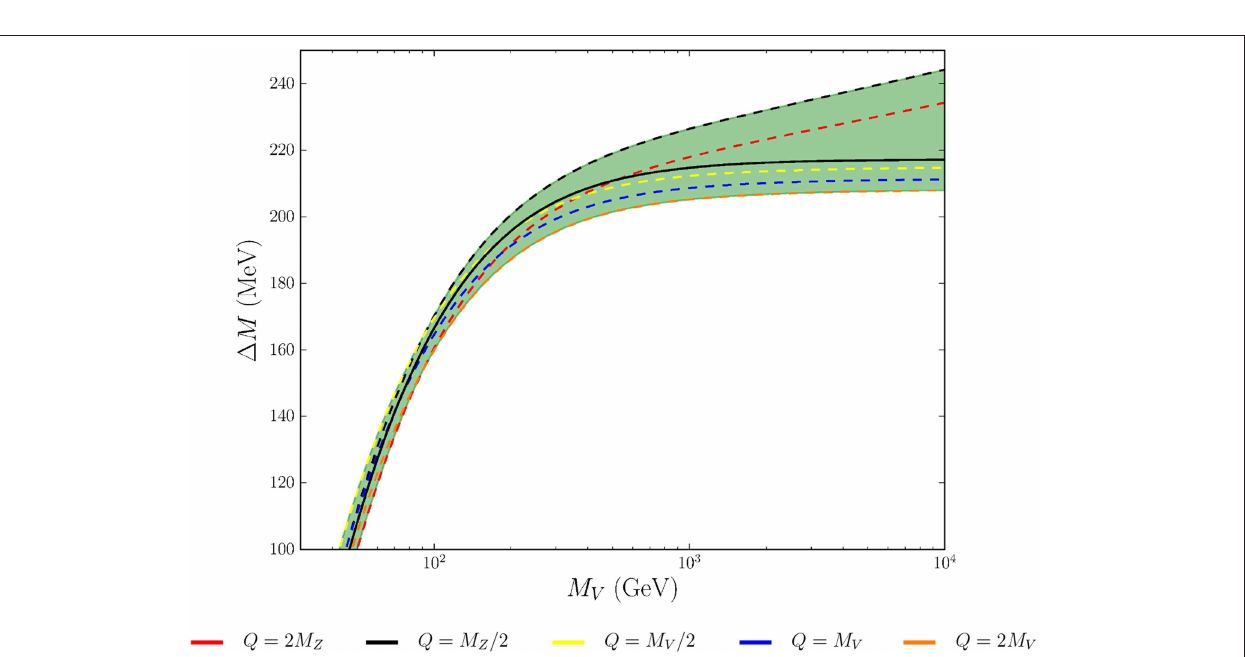
FIGURE 6 | The one-loop radiatively induced mass splitting between the charged and neutral components of the vector DM. The solid lines represent 1 M computed at fixed values of the renormalization scale Q . The shaded green band indicates the range of values obtained by varying Q continuously between min and max 2 M V ,2 M Z and thus constitutes an estimate of the uncertainty on 1 M . The solid black line is the one-loop mass splitting, with all higher order terms { } truncated [36].